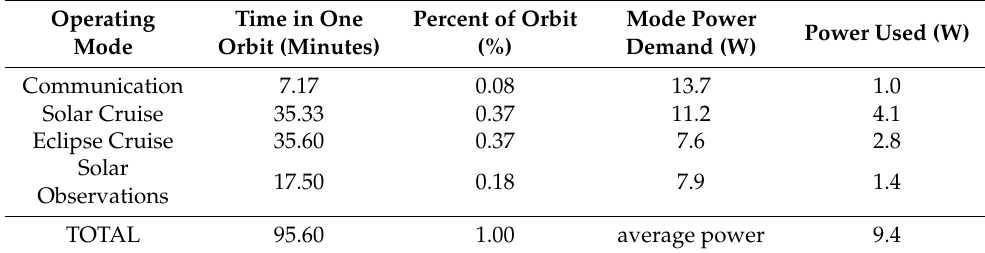
Table 11. Average orbital power requirements for an orbit that include Communication.